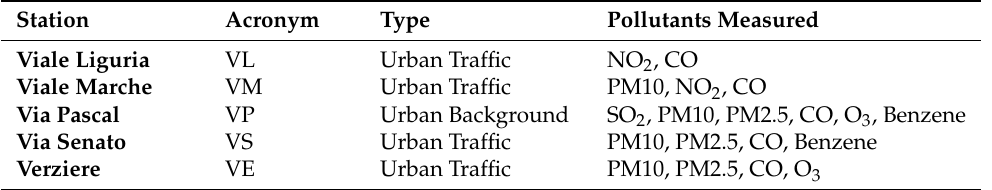
Figure 1. Location of ARPA Lombardia air quality monitoring stations in Milan urban area (Italy). Table 1. ARPA Lombardia air quality monitoring stations